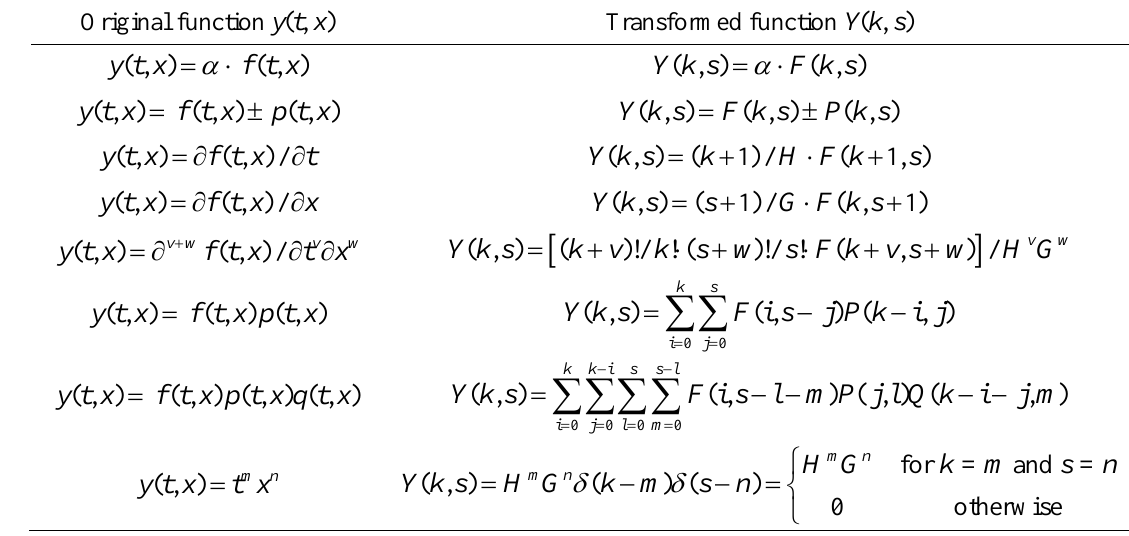
Table 1. Fundamental operations of two-dimensional differential transform.